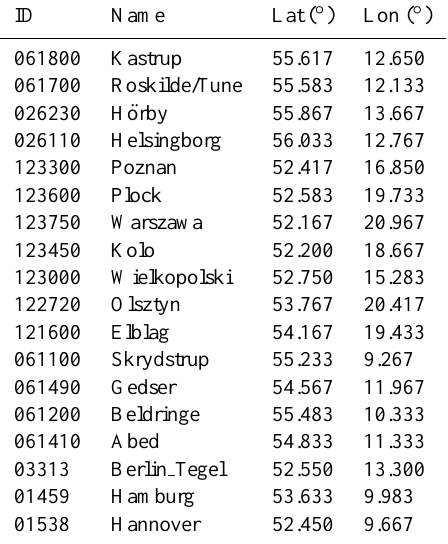
Table A2d. Geographical coordinates of precipitation stations ob- tained from National Centre for Environmental Prediction (NCEP) and Deutscher Wetterdienst (only German